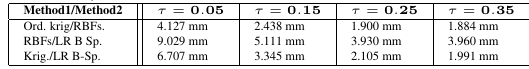
Table 6: Table of results for the averaged rainfall distance (mea- sured in mm) between sets of local maxima. Method1/Method2 τ = 0 . 05 τ = 0 . 15 τ = 0 . 25 τ = 0 . 35 Ord. krig/RBFs.